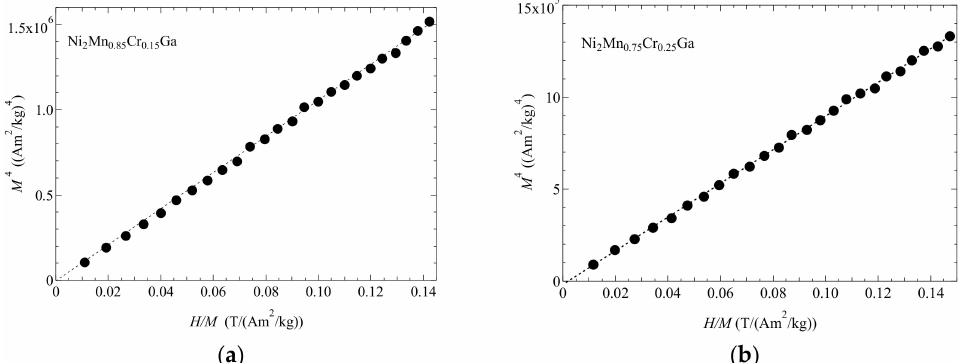
Figure 3. The H / M dependence of M 4 for ( a ) x = 0.15 and ( b ) x = 0.25 at T c. The dotted straight line is the fitted